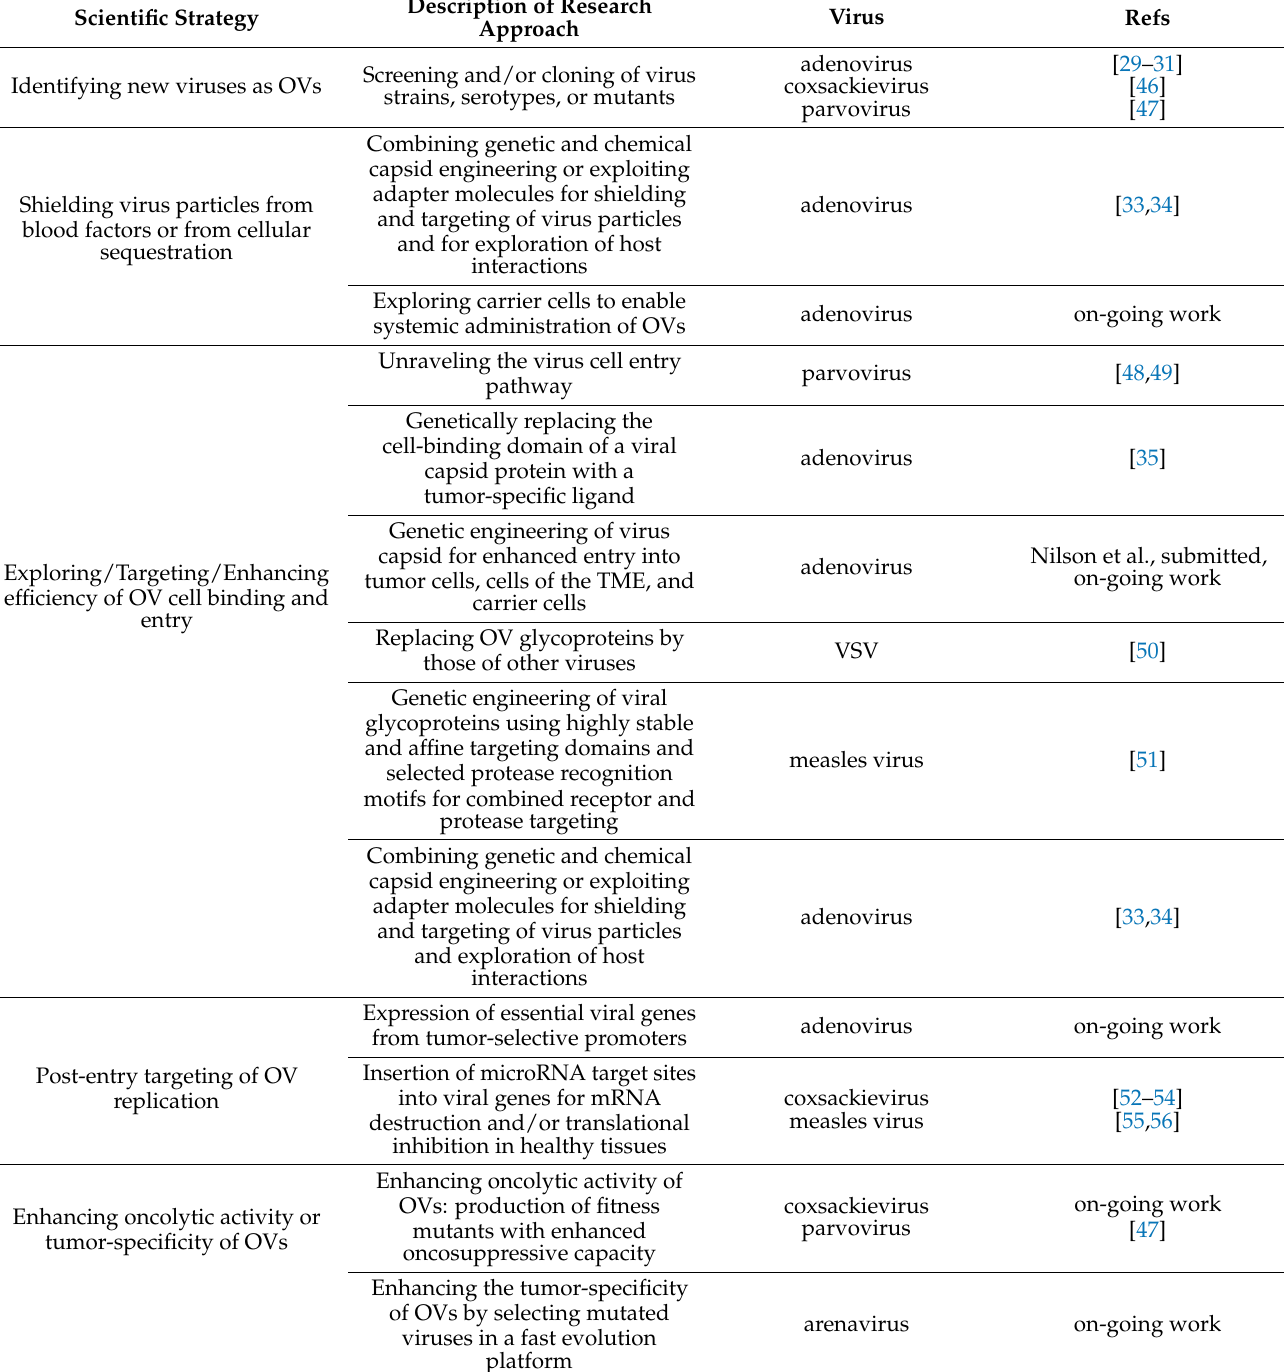
Table 1. Recent preclinical virotherapy research activities in Germany according to scientific